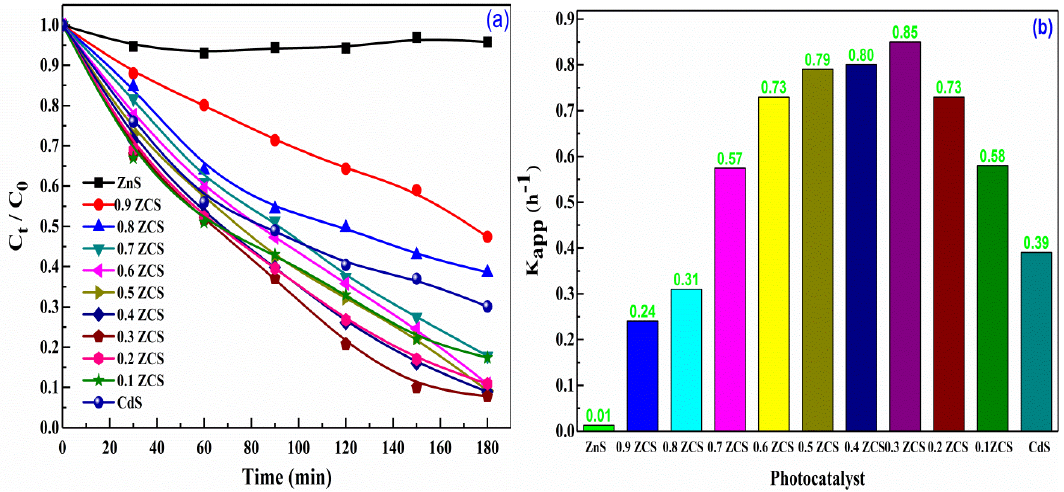
Figure 7. ( a ) Photocatalytic degradation of MO on the prepared xZCS samples; ( b ) K app values of the prepared xZCS samples of the photocatalytic degradation of MO under visible light (> 420 nm) irradiation.